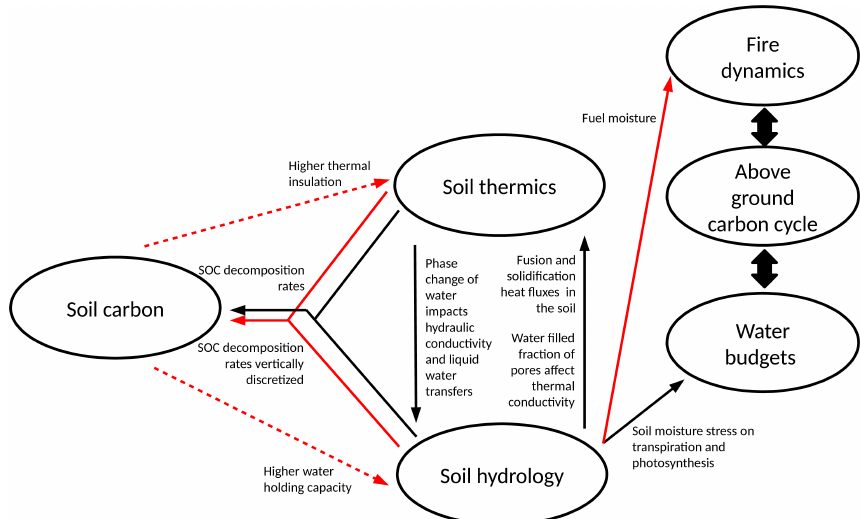
Figure 1. Temperature, water and carbon interactions in the initial version of ORCHIDEE (black), and processes included in ORCHIDEE- MICT in this study (red). Note that in the simulations in this study, the soil thermics and hydrology modules read a prescribed observation- based soil carbon map (see Eq. 9), which is independent of the prognostically simulated SOC by the carbon module; thus, the two red arrows here are dashed